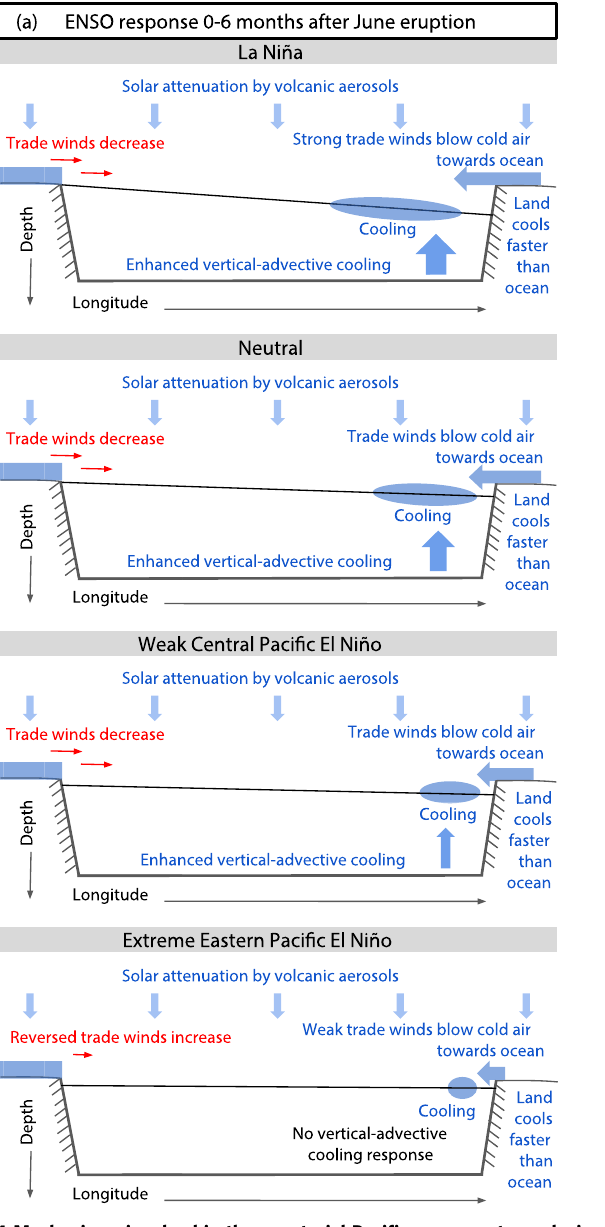
Fig. 4 Mechanisms involved in the equatorial Paci fi c response to explosive low-latitude volcanic eruptions. Schematic of the mechanisms involved in the equatorial Paci fi c response to explosive low-latitude volcanic eruptions a 0--6 months and b 6--18 months after the eruption, for different ENSO preconditioning: La Niña, Neutral, weak Central Paci fi c (CP) El Niño, and extreme Eastern Paci fi c (EP) El Niño. See Experimental setup for ENSO event de fi nitions. The deterministic responses of the land and sea surface temperature and trade winds (Fig. 3a, d, g, j) are shown. The control sea surface height (SSH) is shown as dashed black line, the SSH after the volcanic perturbation is shown as solid black line. The control SSH differs between a and b due to transition to the relaxation